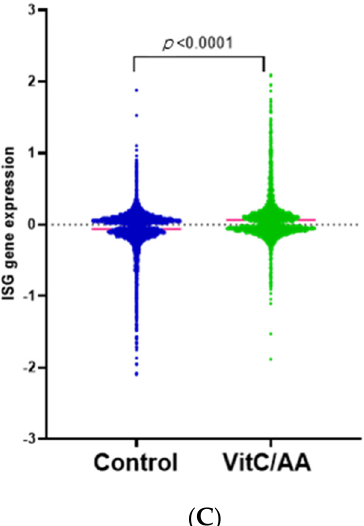
Figure 2. Transcriptomic changes in BEAS-2B cells after treatment with vitamin C. RNA-sequencing was performed on vitamin-C-treated and untreated BEAS-2B cells. ( A ) Selected canonical pathways of upregulated and downregulated differentially transcribed genes in control ( n = 3) and vitamin-C-treated ( n = 3) cells after Ingenuity Pathway Analysis ( − log10 p value ≥ 1.30). ( B ) Gene network analysis of up- and downregulated genes in control ( n = 3) and vitamin-C-treated ( n = 3) cells. The networks shown are among those with the highest significance of connections between molecules in the network, as indicated by their score. Blue nodes indicate downregulated and red nodes indicate upregulated gene expression in vitC-treated vs. control cells. Darker shades of the nodes indicate larger differential expression ratios. Dotted lines represent indirect interactions, while solid lines represent direct interactions. ( C ) RNA expression of ISGs as determined by the Interferome database. Based on the Interferome database of more than 25,000 ISGs, 7838 differentially expressed genes were identified in vitC-treated vs. control cells, 4313 of which were ISGs. These ISGs were expressed at statistically lower levels ( t -test p -value < 0.0001) in control cells ( n = 3) compared to vitC-treated cells ( n = 3).